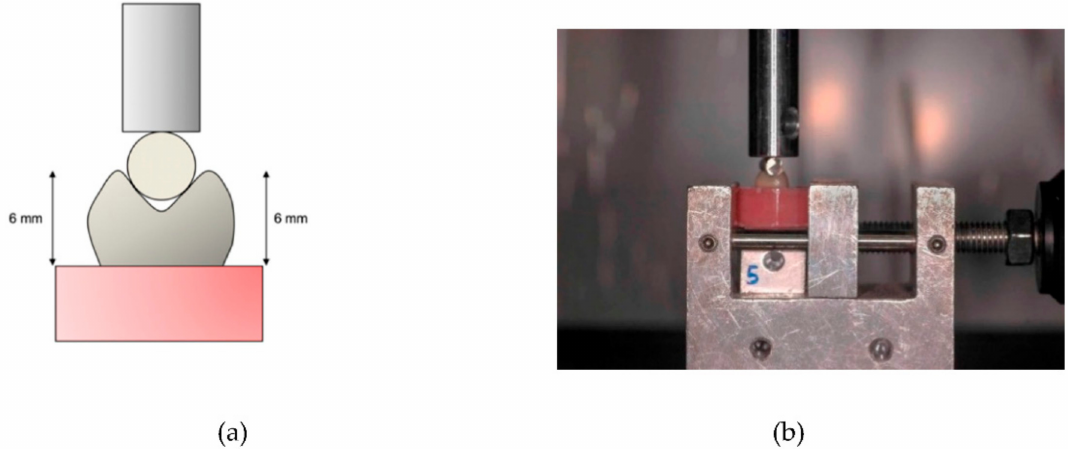
Figure 3. Indirect tensile fracture test. ( a ) Schematic drawing. Load was applied between cusps with a round metal bar to which an upper rod was connected. This was designed to apply force to surfaces at equal levels. ( b ) Photograph of a specimen placed for indirect tensile fracture test of this study.